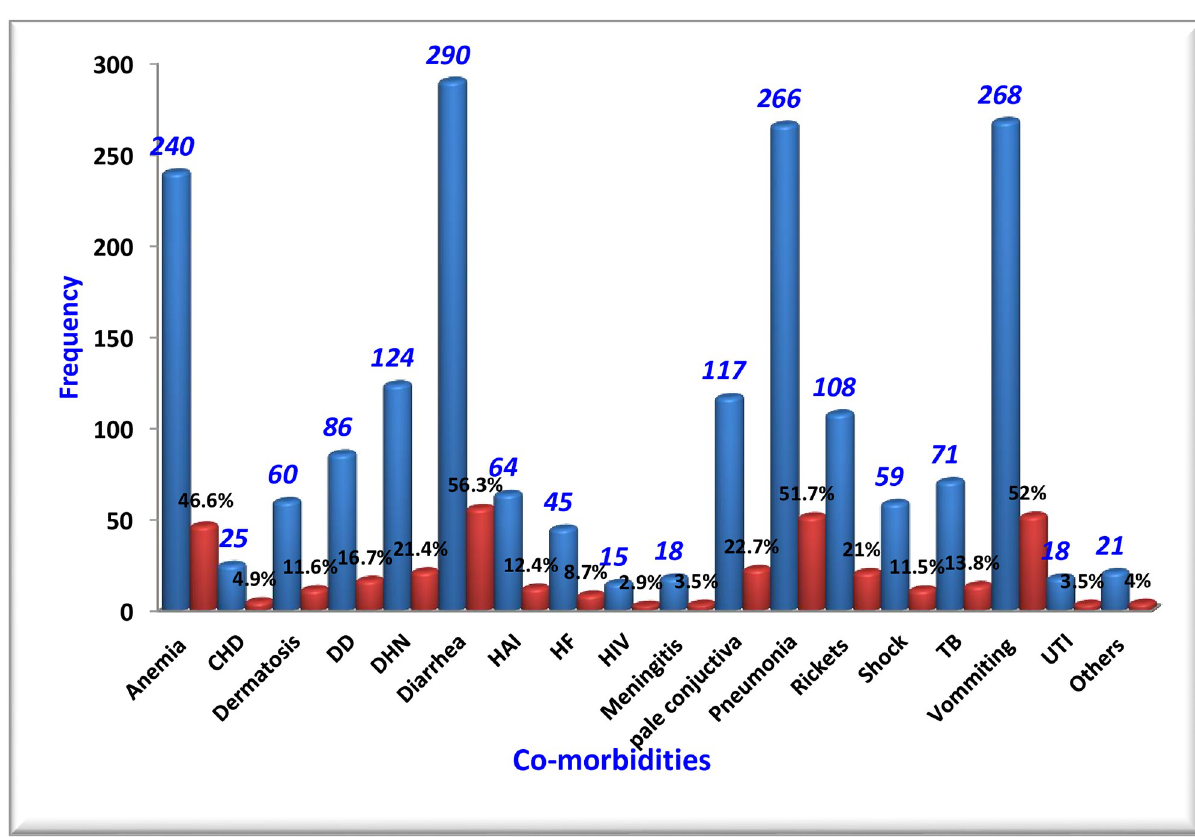
Fig 2. Co-morbidities of SAM children at SPHHMC from 2012 to 2019, Addis Ababa, Ethiopia, 2019. TB : Tuberculosis; DHN : Dehydration; DD : Developmental Delay; UTI ; Urinary Tract Infection HAI : Hospital Acquired infections: CHD : Congenital heart Diseases; HF : Heart Failure.